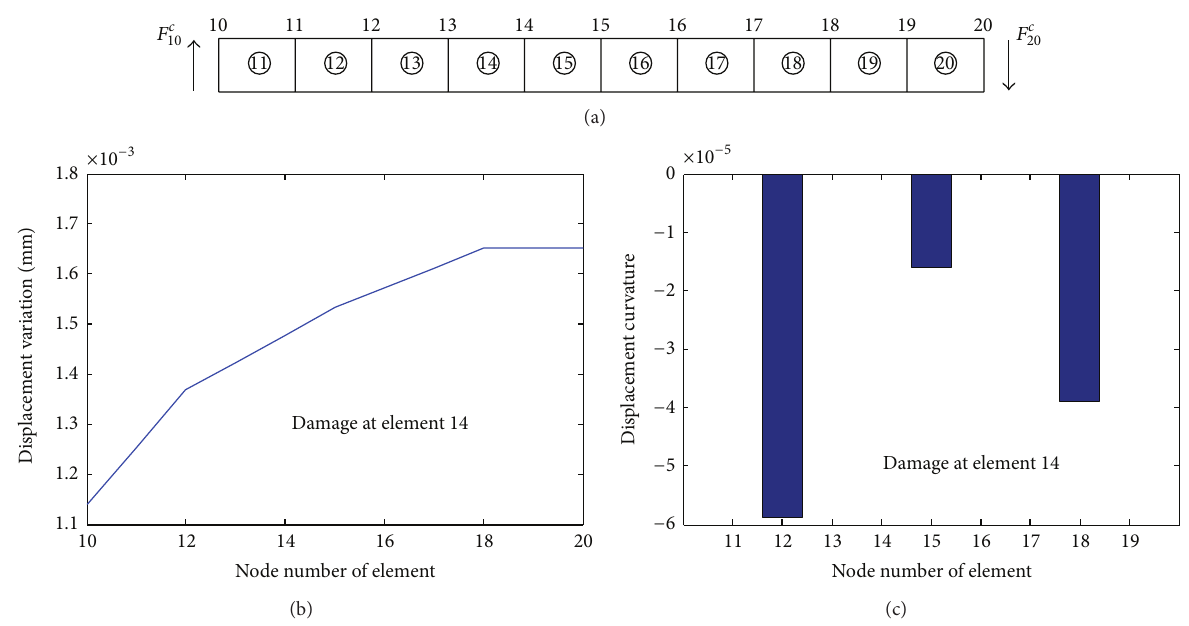
Figure 6: Damage detection of the second substructure: (a) modeling of isolated substructure, (b) displacement variation, and (c) dis- placement